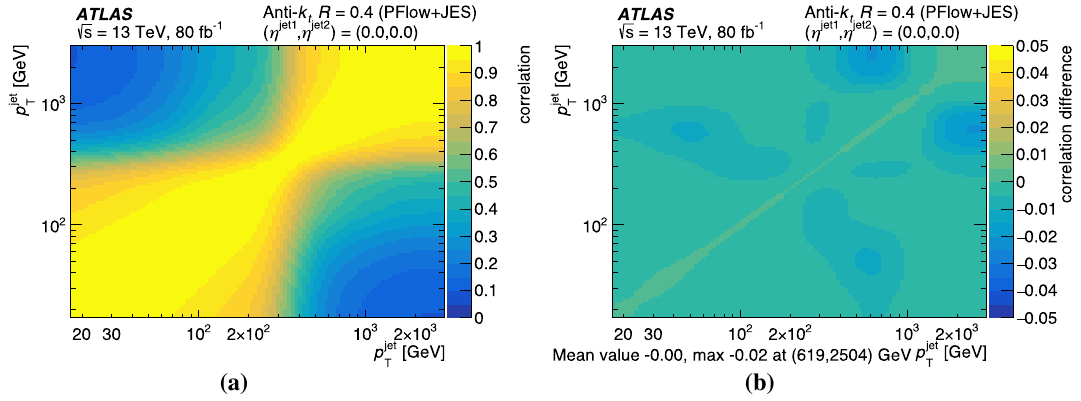
Fig. 23 a The jet energy scale correlation matrix for two PFlow+JES jets at η = 0 using the full set of 98 p T -dependent in situ nuisance parameters and b the difference in correlation information between the